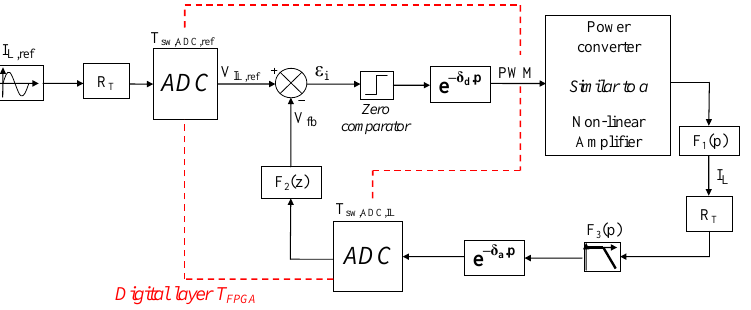
Figure 8. DPSSOCC proposed model.